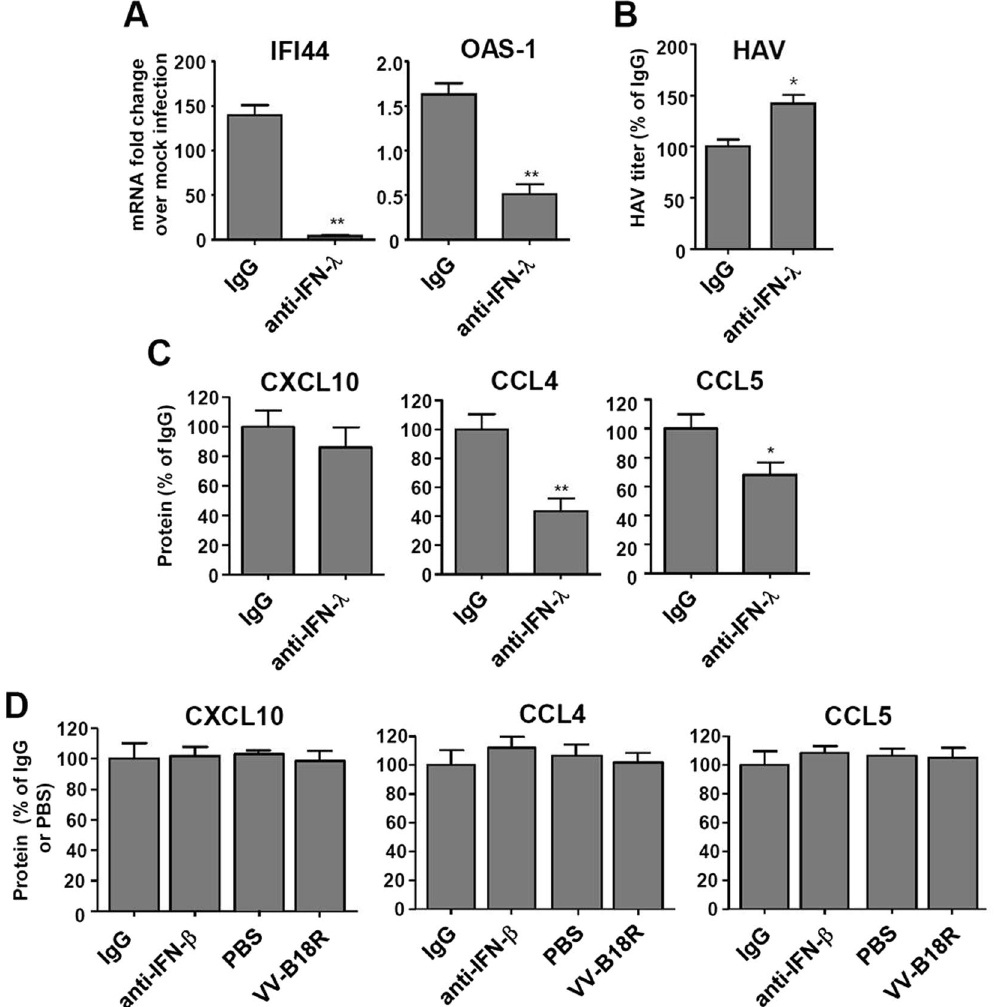
Figure 4. Effects of neutralizing IFN- λ on the production of chemokines in HAV-infected cells. ( A – D ) Anti- IFN- λ , anti-IFN- β , or VV-B18R was added to the HepG2 cell culture 30 minutes prior to HAV infection (200 GE/cell), and maintained until harvesting. After 48-hour culture, real-time qPCR was performed to examine the effect of anti-IFN- λ on IFI44 and OAS-1 induction ( A ). After 48-hour culture, real-time qPCR was performed to examine intracellular HAV RNA copies ( B ). After 24-hour culture, culture supernatants were harvested and ELISA was performed to examine the production of CXCL10, CCL4, and CCL5 ( C , D ). Bar graphs represent the means ± s.e.m. (n = 3). Unpaired t-tests were performed. * P < 0.05, ** P < 0.01 compared to PBS or